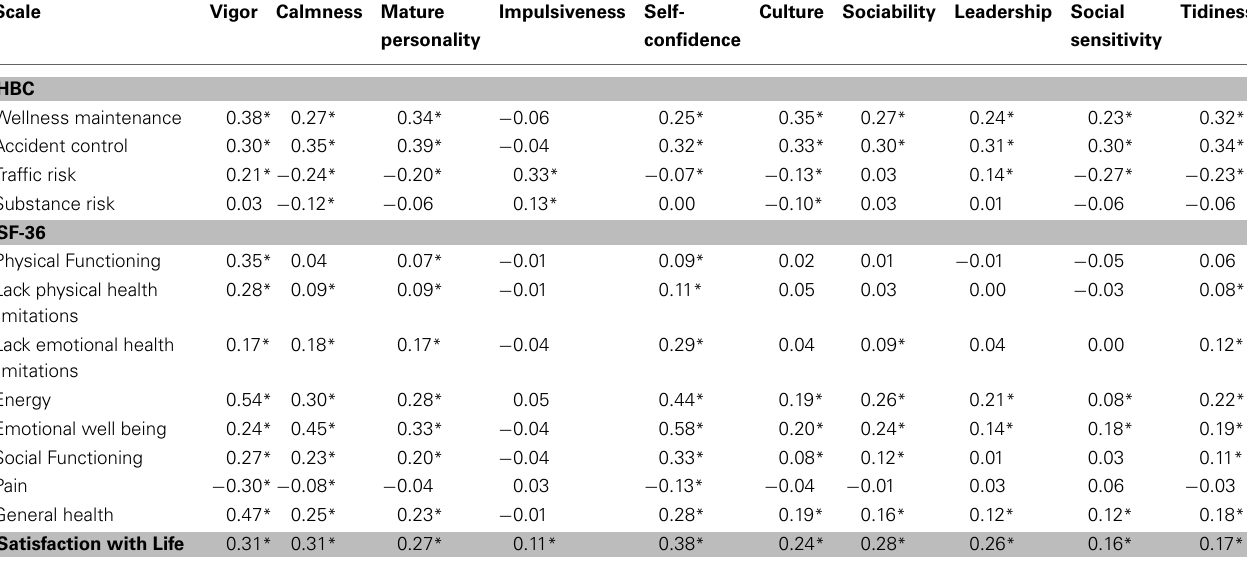
Table 6 | Correlations between the PTPI scales, well-being, physical health, and life satisfaction.